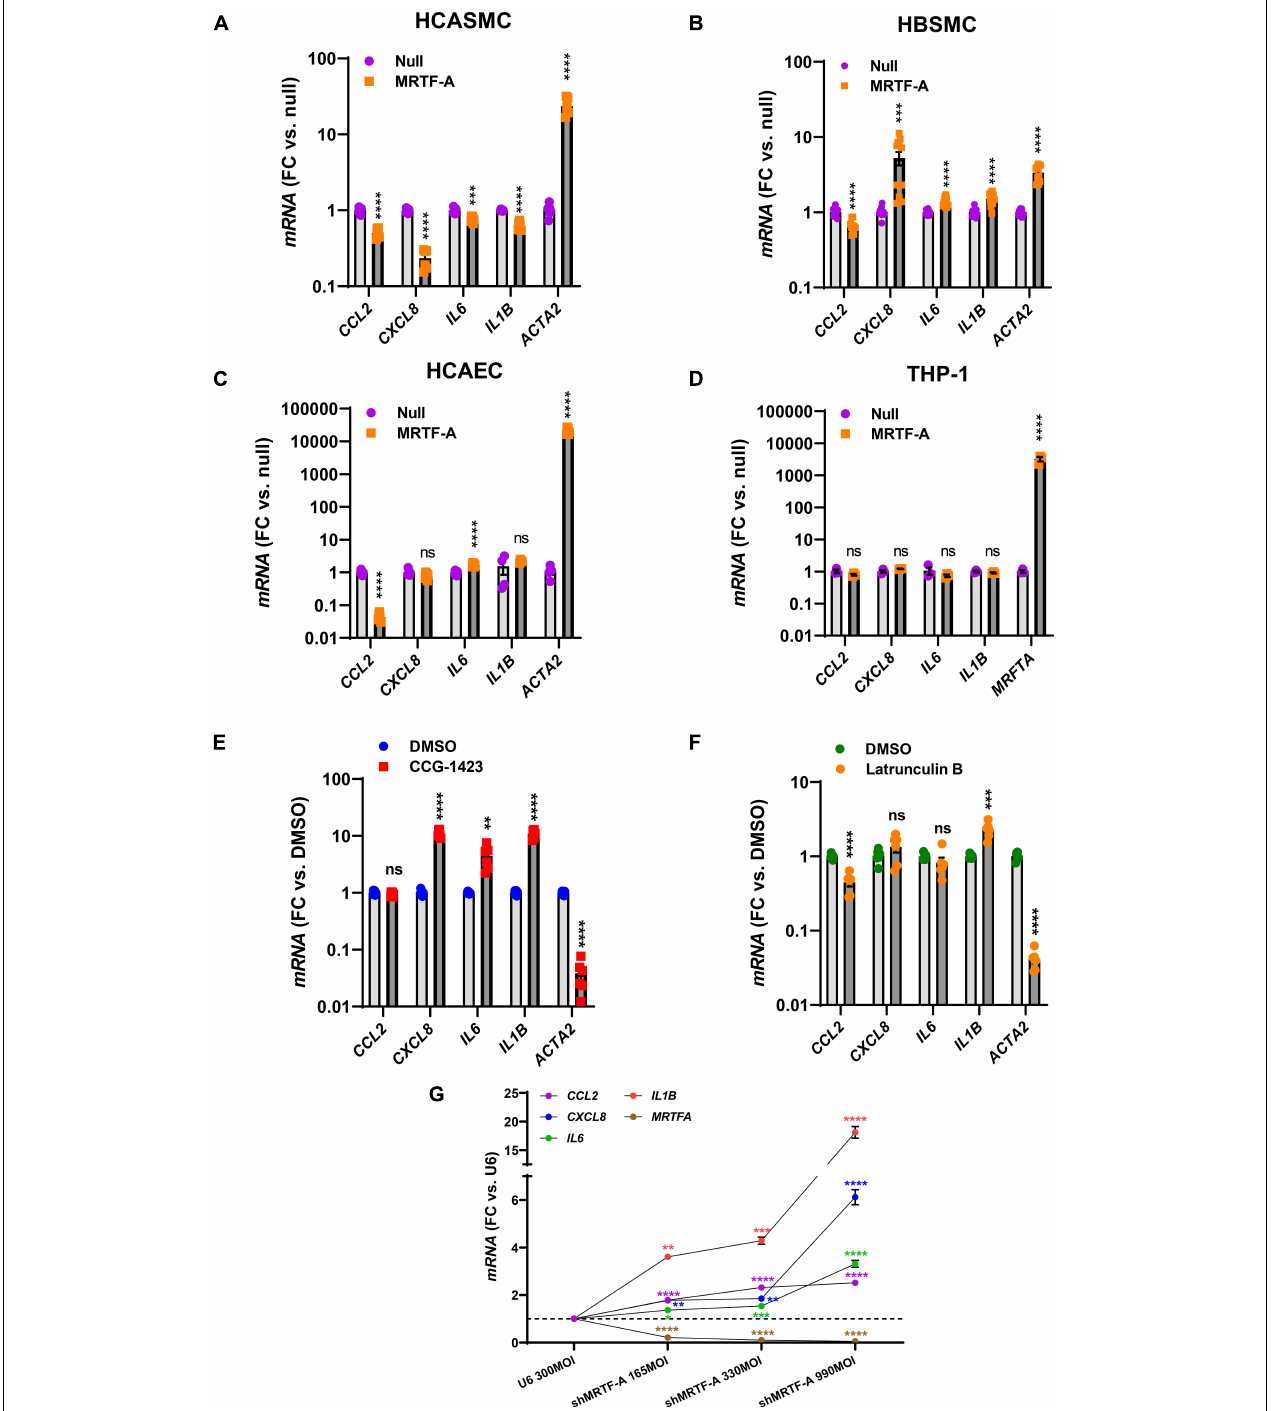
FIGURE 3 | The anti-inflammatory impact of MRTF-A is cell type-dependent. To compare the impact of MRTF-A on inflammation in different cell types, MRTF-A was overexpressed using an adenoviral vector, and using a null vector as control. (A–D) Show the effect of MRTF-A on CCL2 , CXCL8 , IL6 , and IL1B in human coronary artery SMCs (hCASMC, (A) ), human bladder SMCs (hBSMC, (B) ), human coronary artery endothelial cells (hCAEC, (C) ), and monocytes (THP-1 cells, (D) ). ACTA2 was used as positive control in all panels except for THP-1 cells where we instead assayed MRTFA itself. (E) Shows the effect of the MRTF inhibitor CCG-1423 (10 µ M) in hCASMC transduced with MRTF-A. (F) Shows the effect of Latrunculin B (100 nM), which depolymerizes actin, on the inflammatory transcripts in hCASMC. (G) Shows inflammatory mediators determined by RT-qPCR after silencing MRTF-A using different titers of a short hairpin virus (shMRTF-A). In this experiment U6 represents the control virus. * P < 0.05, ** P < 0.01, *** P < 0.001, **** P < 0.0001.